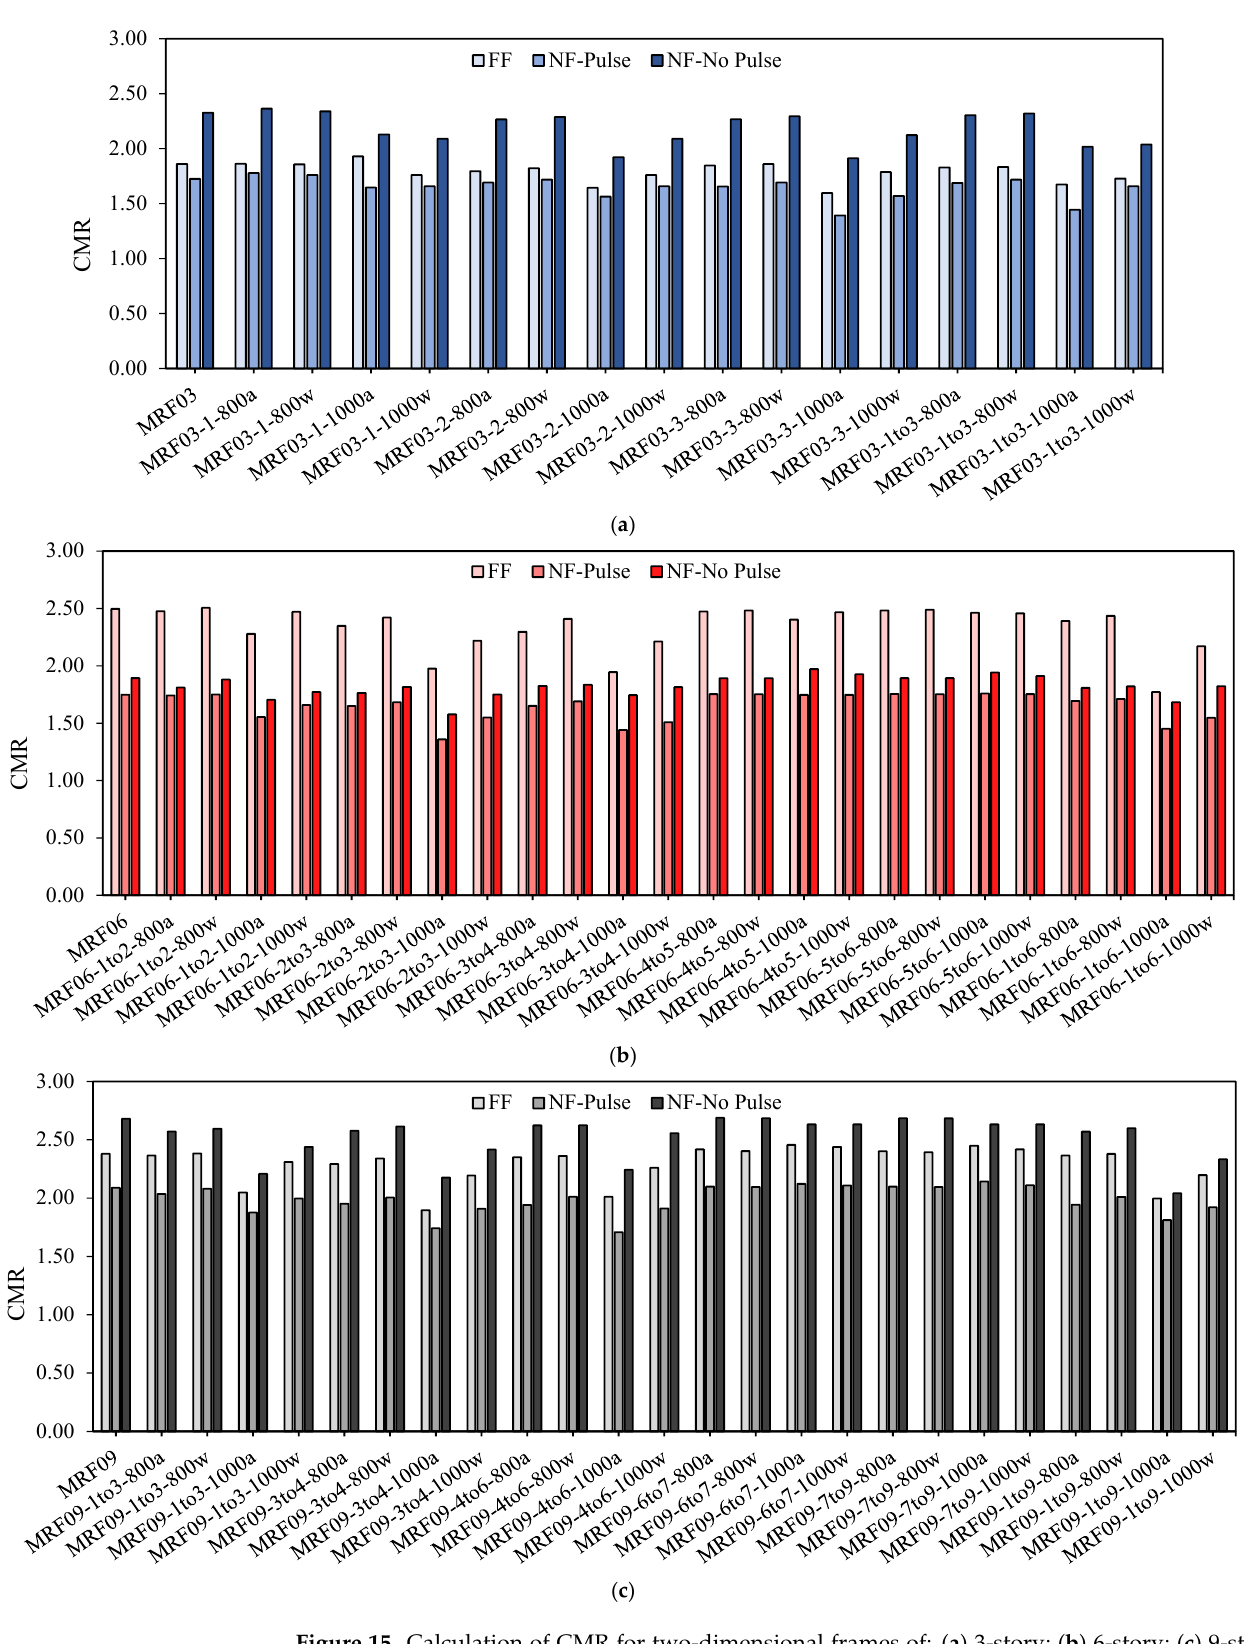
Figure 15. Calculation of CMR for two-dimensional frames of: ( a ) 3-story; ( b ) 6-story; ( c ) 9-story structure.